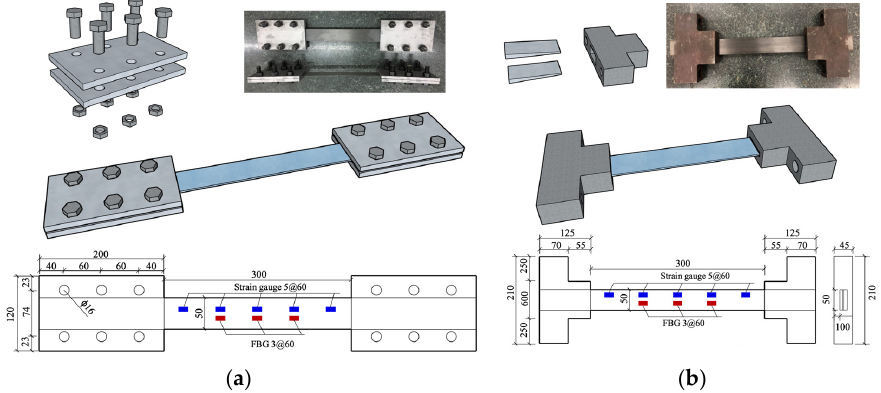
Figure 1. Clamp anchor ( a ) and wedge anchor ( b